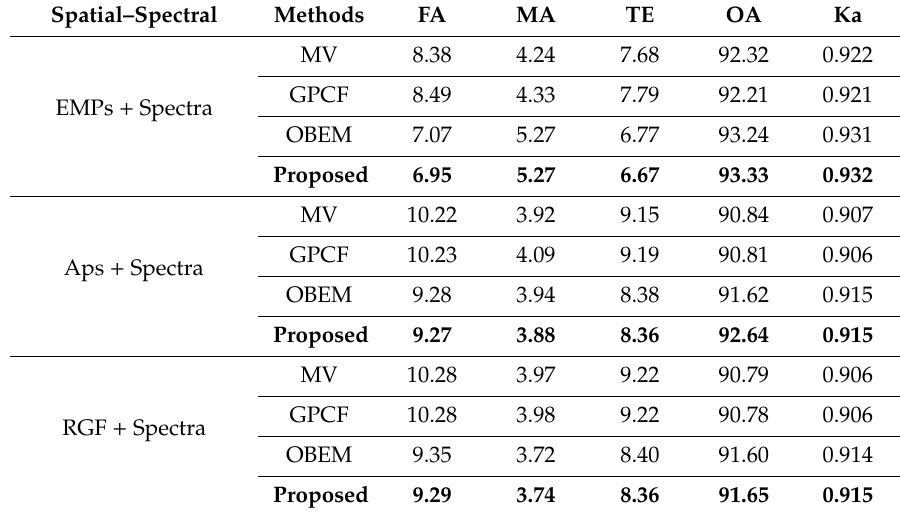
Table 9. Quantitative comparisons (%) between the proposed approach and three post-processing methods with di ff erent spatial–spectral feature fusion strategies in the Ji’Nan QB satellite images. Spatial–Spectral